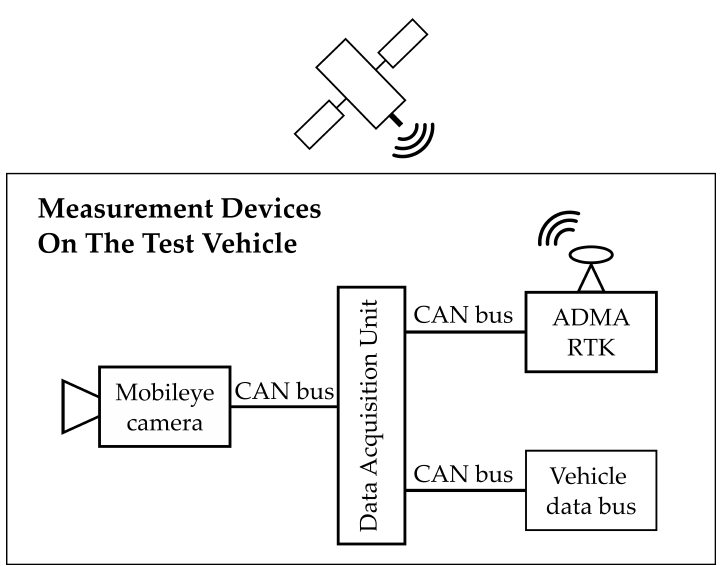
Figure 2. Measurement setup for measuring